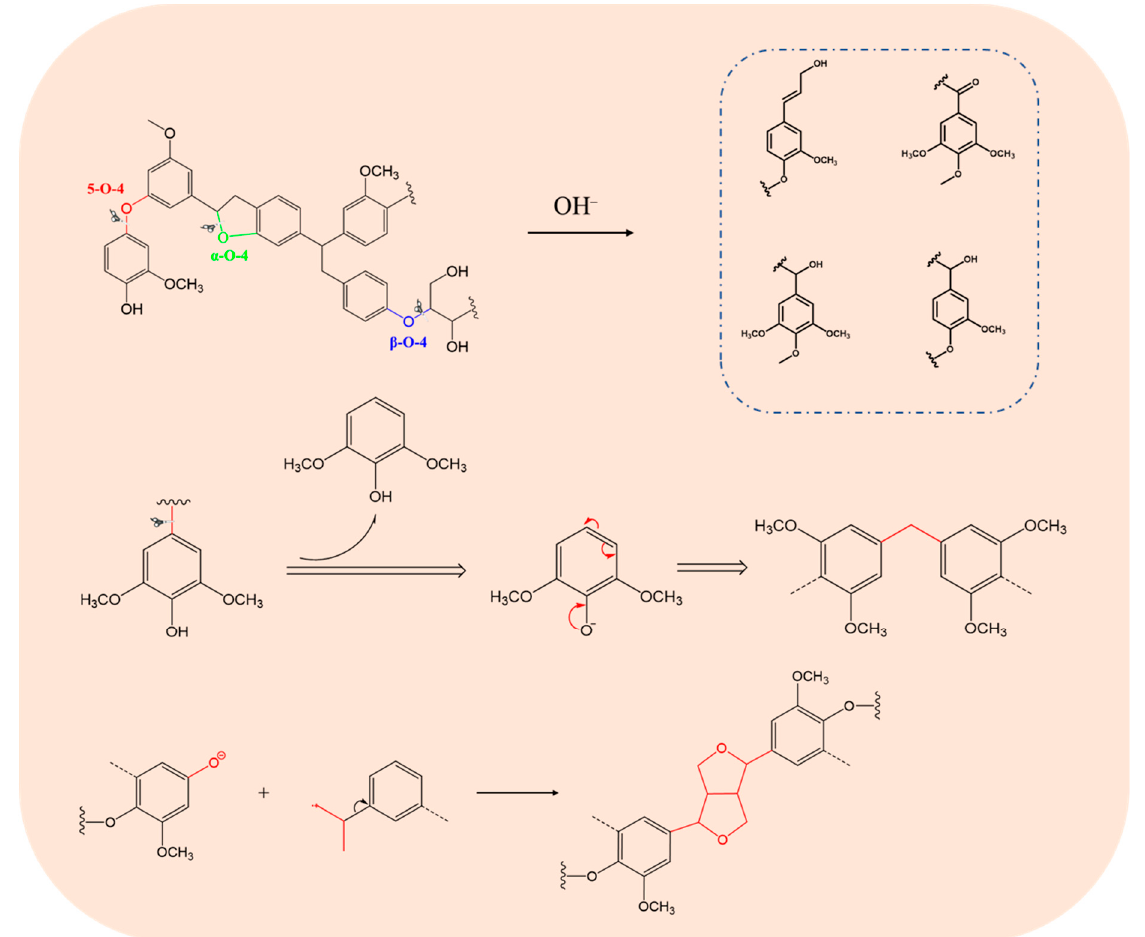
Figure 2. Reported mechanisms of lignin degradation and polymerization.